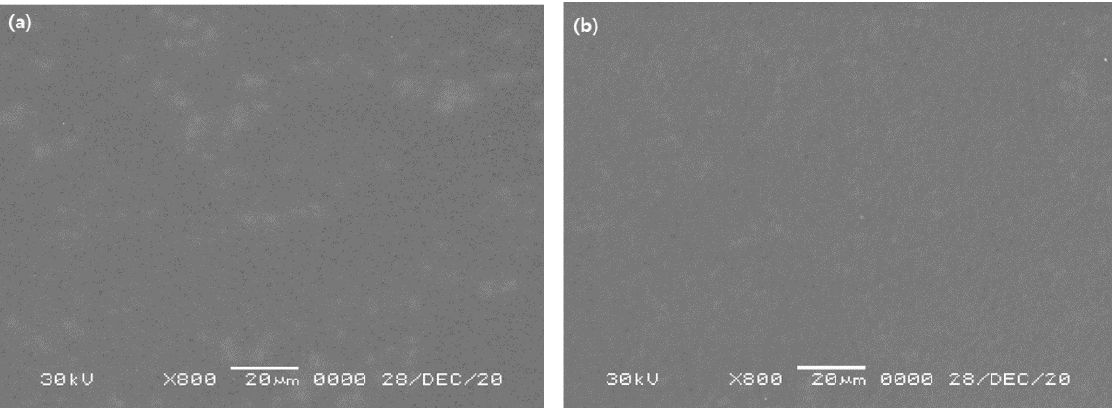
Membranes 2021 , 11 , x